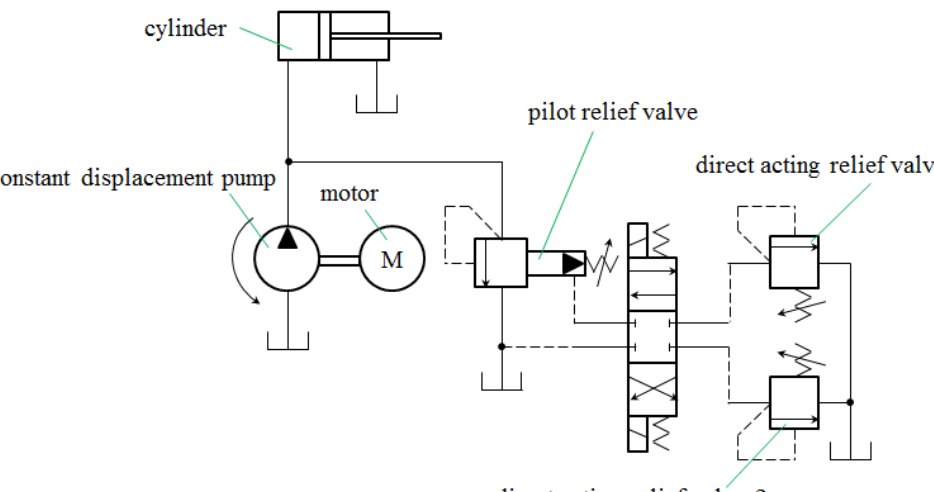
Figure 7. The multi-stage pressure control circuit.